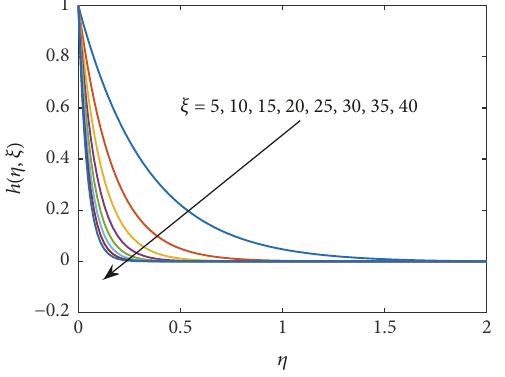
Figure 5: Concentration profiles at different values of 𝜁 , 𝑁 𝜂 = 60 , 𝑁 𝜁 = 5 , 𝑛 = 𝑤 = 1/2 , 𝑃𝑟 = 0.7 , 𝑆𝑐 = 0.6 , and 𝑧 = 40 .